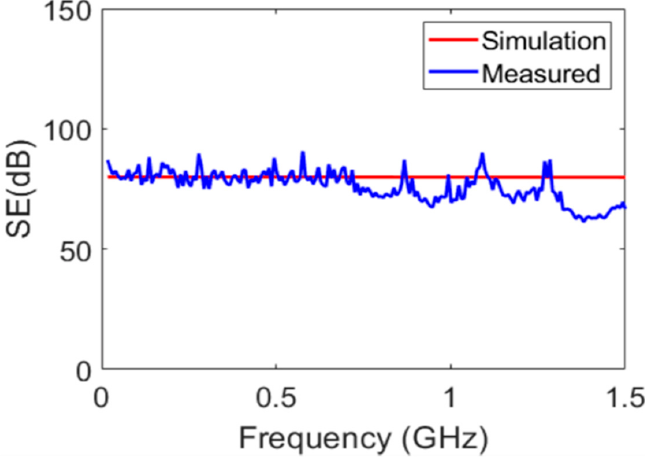
Figure 8. Measured total shielding effectiveness of three polymer materials.